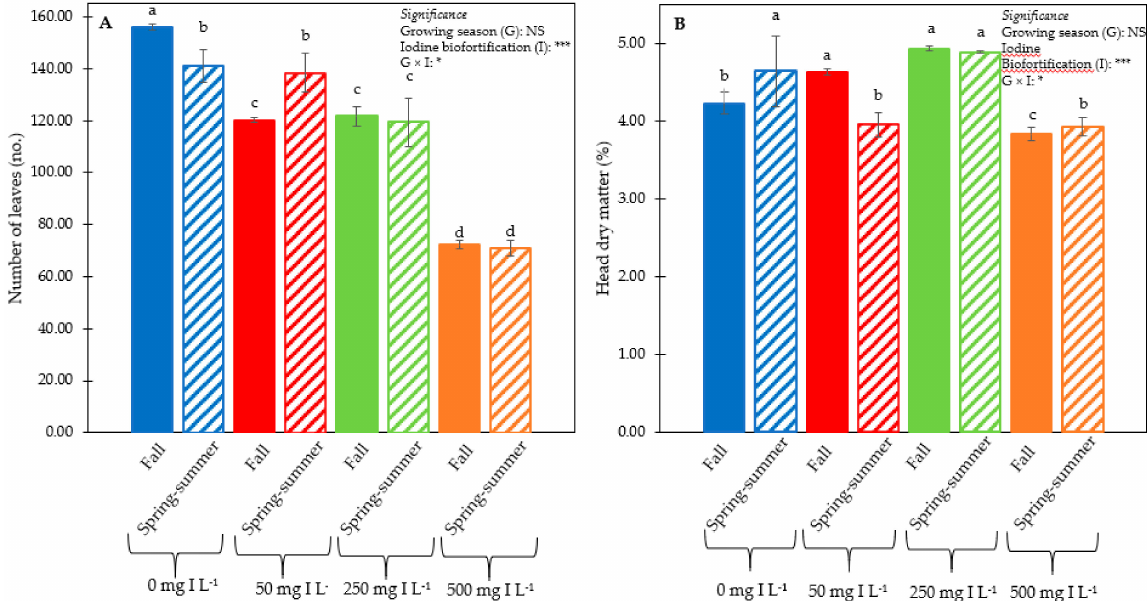
Figure 3. Number of leaves ( A ) and head dry matter ( B ) as affected by combining the growing season (fall or spring– summer) and iodine supply (0, 50, 250, or 500 mg L − 1 ) in curly endive. Different letters indicate significant differences at p ≤ 0.05. *, *** significant at 0.05 and 0.001, respectively. NS, not